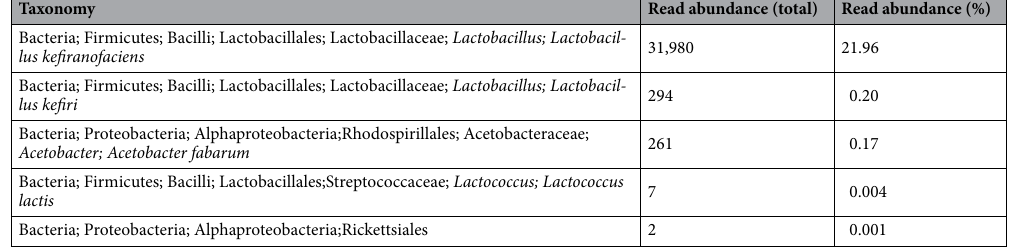
Table 1. 16S-v4 read abundance and taxonomic units.